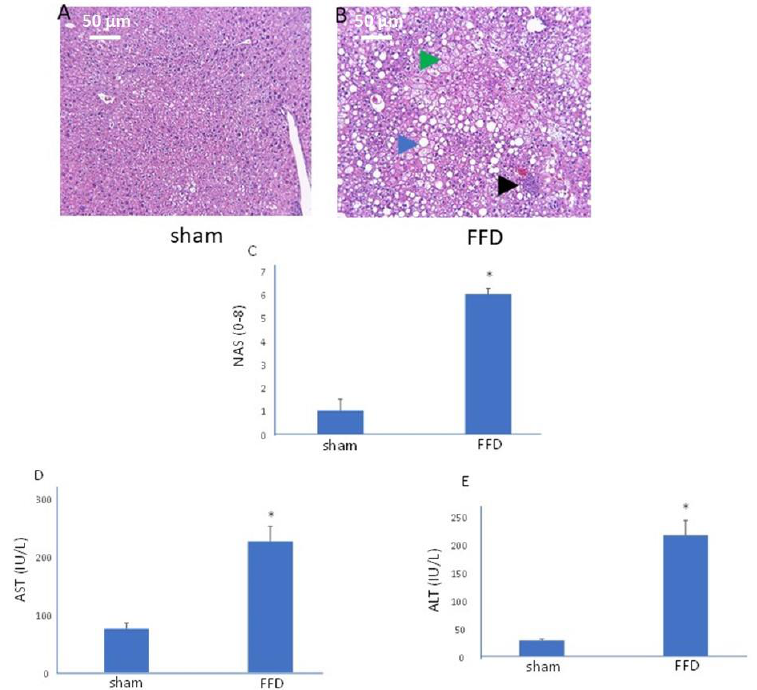
Figure 1. A murine model of diet-induced NASH: ( A ) images of H&E-stained liver sections of mice from the sham cohort; ( B ) Images of H&E-stained liver sections of mice from the FFD cohort. The blue arrow shows lipid droplets, whereas the black arrow highlights inflammation and the green arrow depicts a site of hepatocyte ballooning. ( C ) NAS, ( D ) AST and ( E ) ALT were elevated in the FFD cohort vs. sham. *, p <